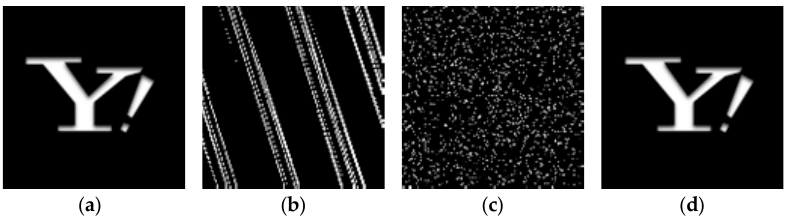
Figure 3. Duel-encrypted watermarked image. ( a ) Original watermark, ( b ) Arnold encrypted image, ( c ) logistic mapped image; ( d ) decrypted image.